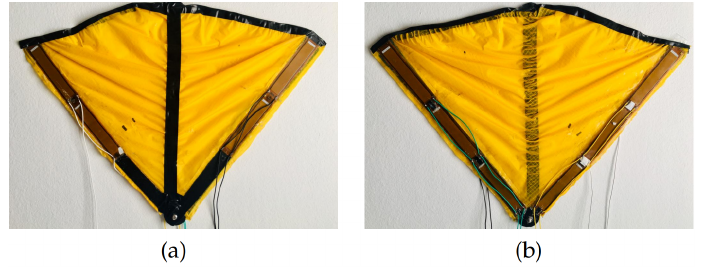
Figure 5. Final Developed Tail Model Prototype. ( a ) Tail upper site. ( b ) Tail bottom